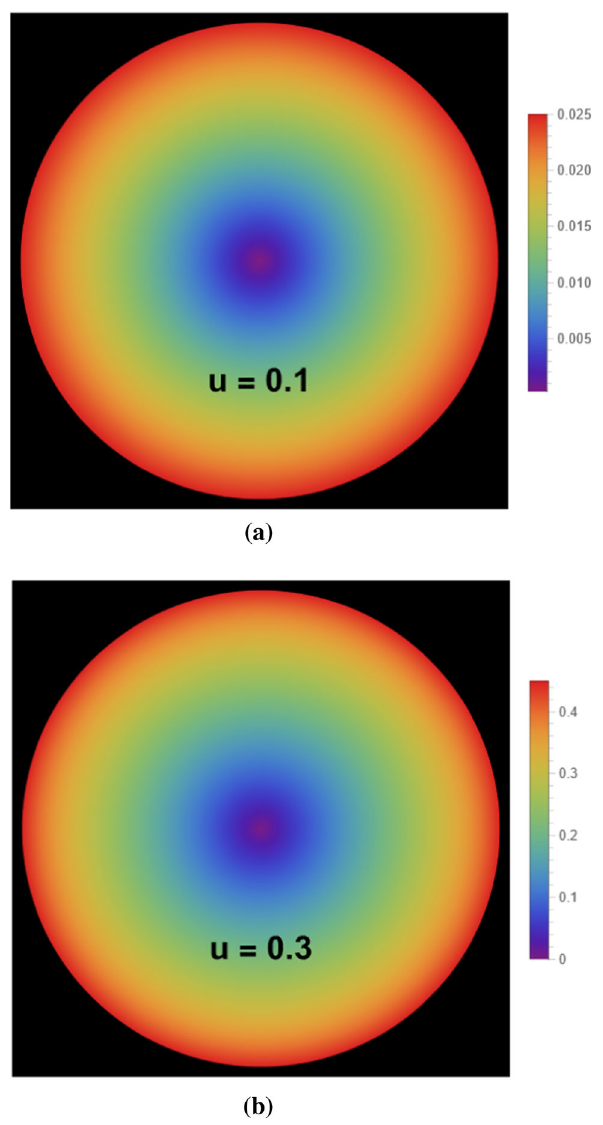
Fig. 10 Density plot of the energy exchange for a u = 0 . 1 and b u = 0 . 3 and (cid:13) = ρ s = 3 C 2